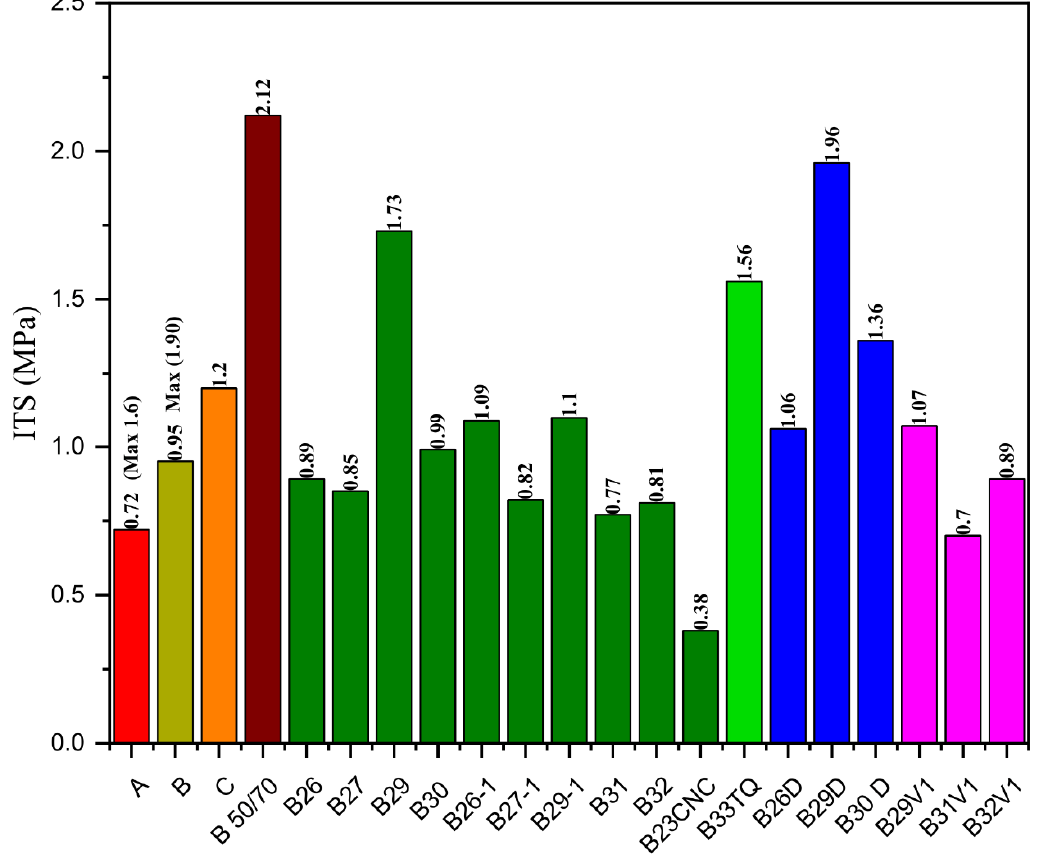
Figure 6. Results of the ITS values at 20 °C for the recycled asphalt mixtures produced with 100% RAP and the alternative binders. Legend: